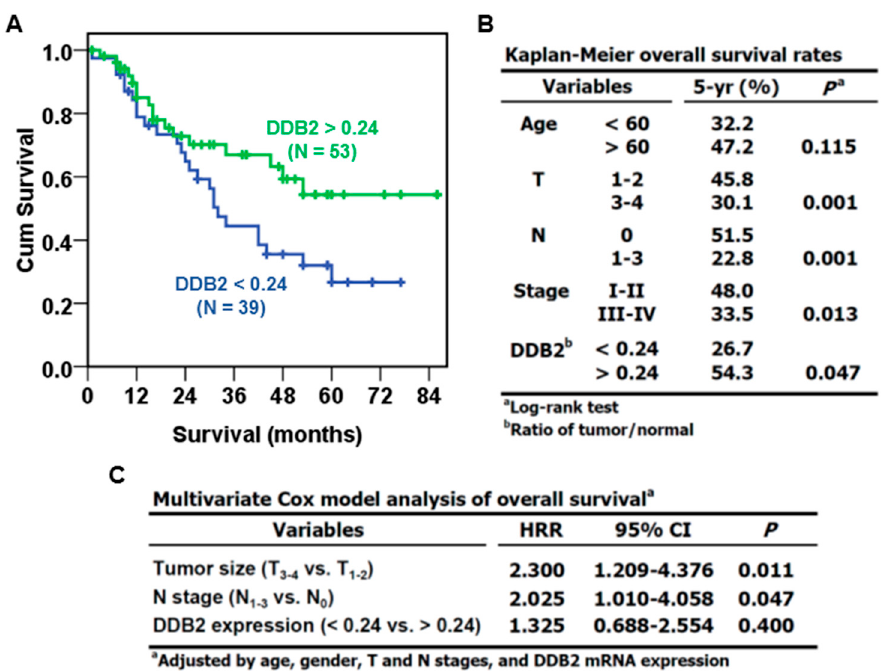
Figure 7. Kaplan–Meier and multivariate Cox regression analyses of overall survival (OS). ( A ) The OS curves of BQ-associated HNC patients (KMUH cohort). ( B ) Patients’ 5-yr OS rate. ( C ) Hazard rate ratio (HRR) of T-, N-stage, and DDB2 mRNA expression calculated by multivariate Cox model. The patients were sub-grouped based on the expression of DDB2 mRNA in tumor tissues versus that in adjacent non-tumor tissues (cutoff: 0.24). N: patient number.